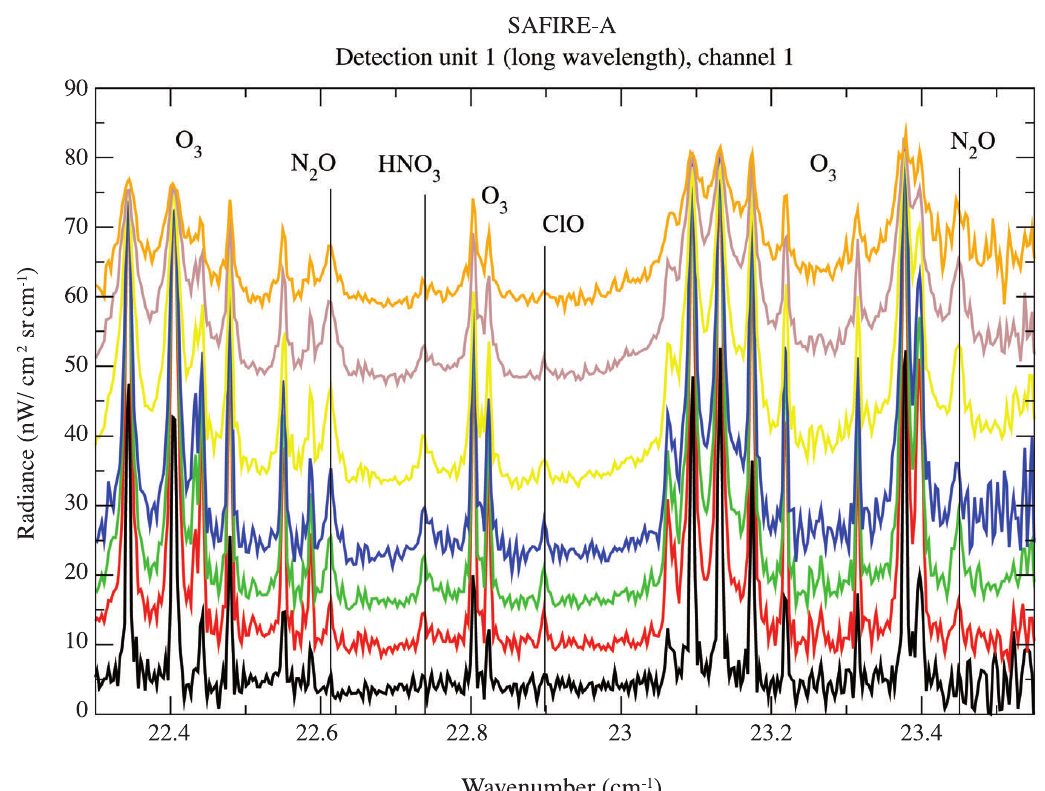
Fig. 14. Limb-scanning sequence of atmospheric emission spectra acquired in the 22-23.5 cm –1 window. Spectral features due to interesting molecular species are evidenced by vertical